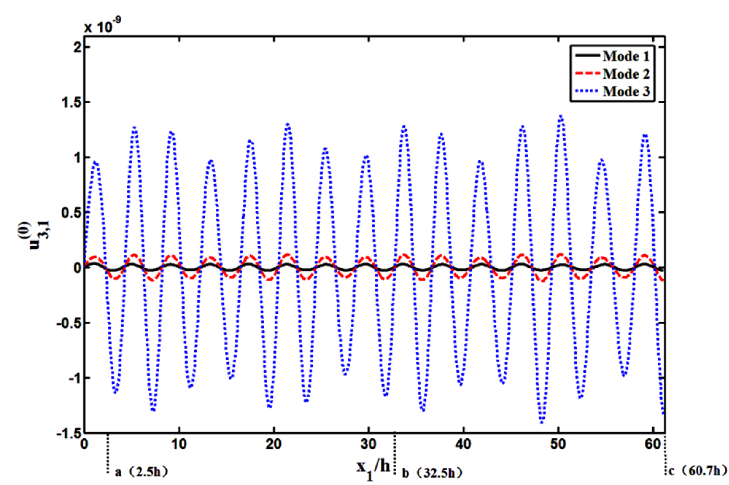
  0 u 2,1 ( 0 )   0 ) near resonance. u ) near resonance. Figure 5. Flexural (F) strain distribution ( 2,1 2,1 ) near resonance.